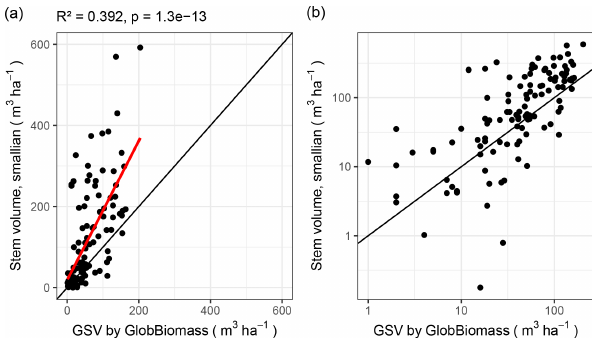
Figure 8. Stem volume calculations plotted against growing stock volume (GSV) from the GlobBiomass data set. (a) Linear scale. (b) Logarithmic scale, with zeroes removed.